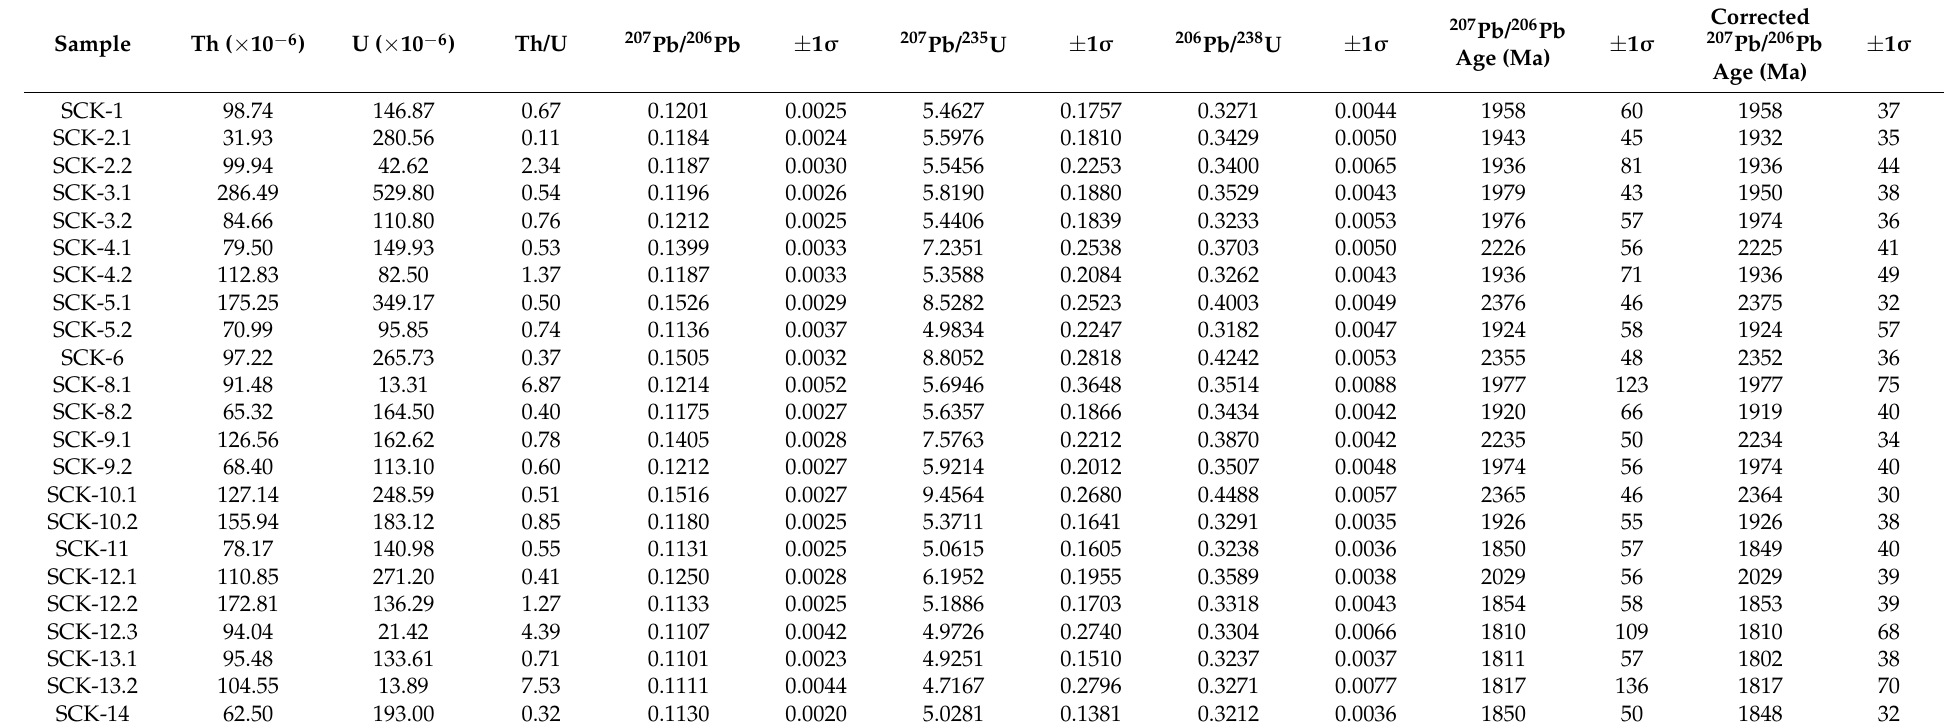
Table 2. The in situ zircon U-Pb isotopic data of the Sanchakou